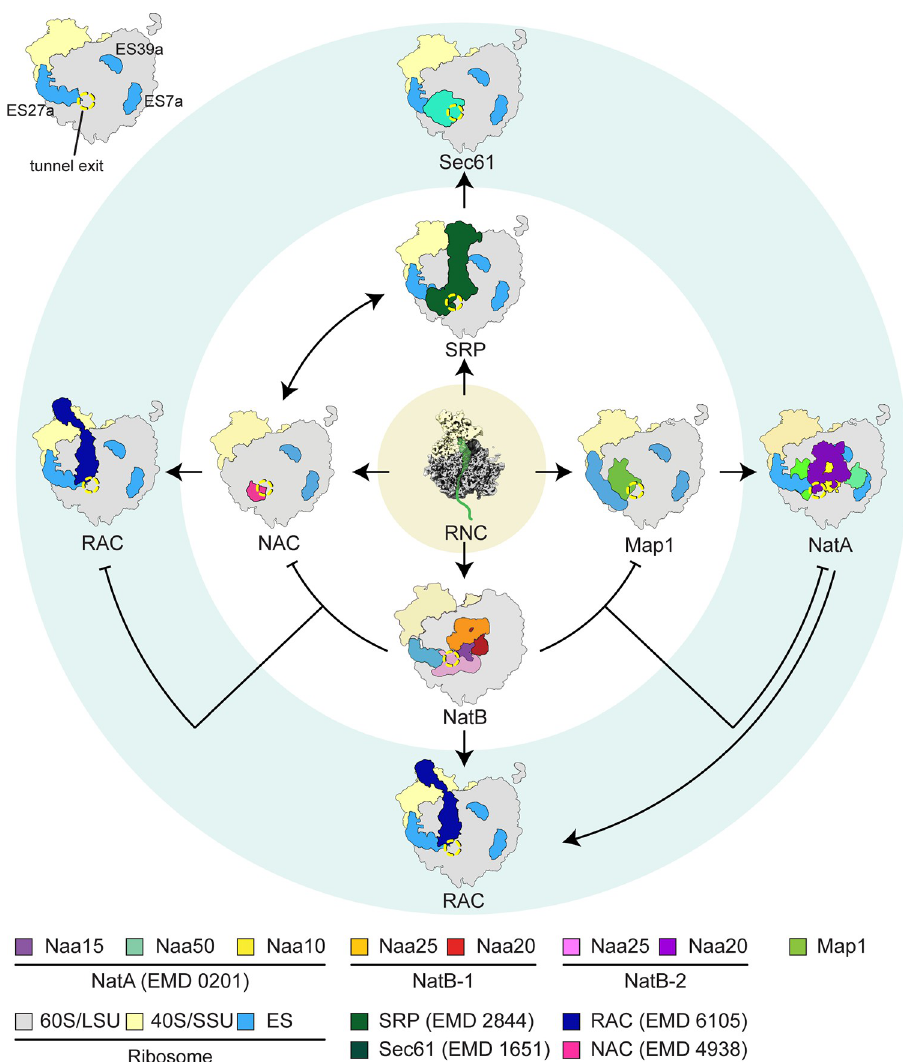
Fig 4. Scheme depicting the possible interplay of ribosome exit site factors. The translating ribosome exposing a nascent polypeptide chain is engaged by primary exit site factors (NAC, Map1, NatB, SRP) depending on the properties of the emerging chain’s N-terminus. After these primary factors have performed their activity, secondary factors (e.g., NatA, RAC, Sec61) gain access to the nascent chain. Whereas some of them can coexist on the ribosome (e.g., NatA and Map1-C1 or NAC and SRP), others cannot or have to bind sequentially (e.g., NatA and NatB). ES: expansion segment, RNC: ribosome-nascent chain complex. The tunnel exit is indicated by a yellow dotted circle. Color codes for factors and entry codes for the electron microscopy database (EMD) are given below. Reference for EMD 2844 is [45], for EMD 6105 is [46], for EMB 1651 is [47], and EMD 4938 is